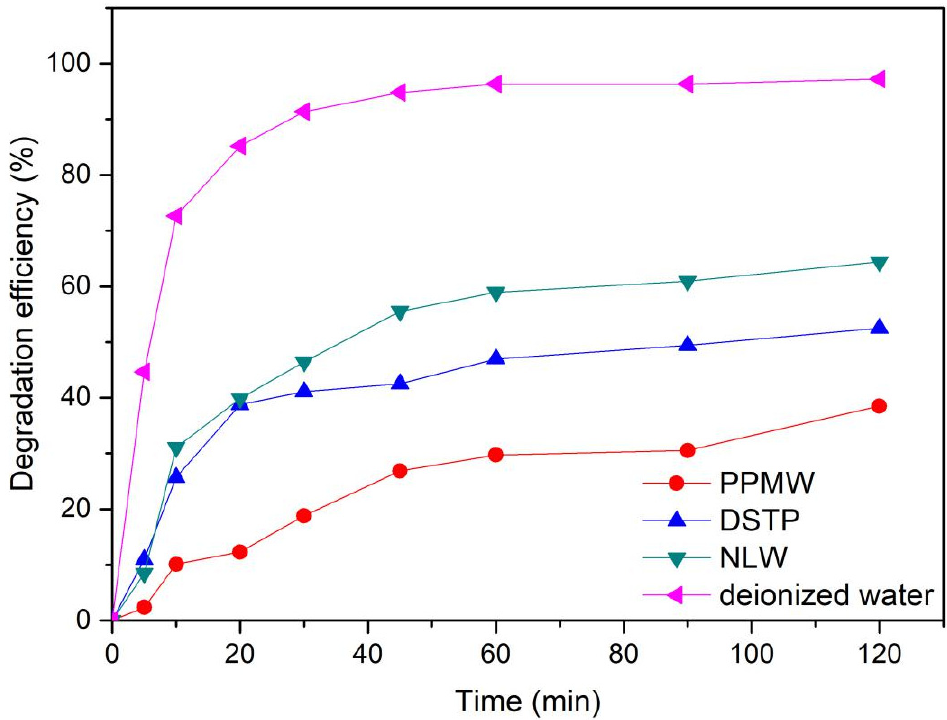
Figure 7. Degradation of 2,4-DCP in natural water bodies. [2,4-DCP] = 20 mg L − 1 , [Fe(III)-EDDS] = 0.1 mM, [H 2 O 2 ] = 1.0 mM, and pH = 7.0 ± 0.1.